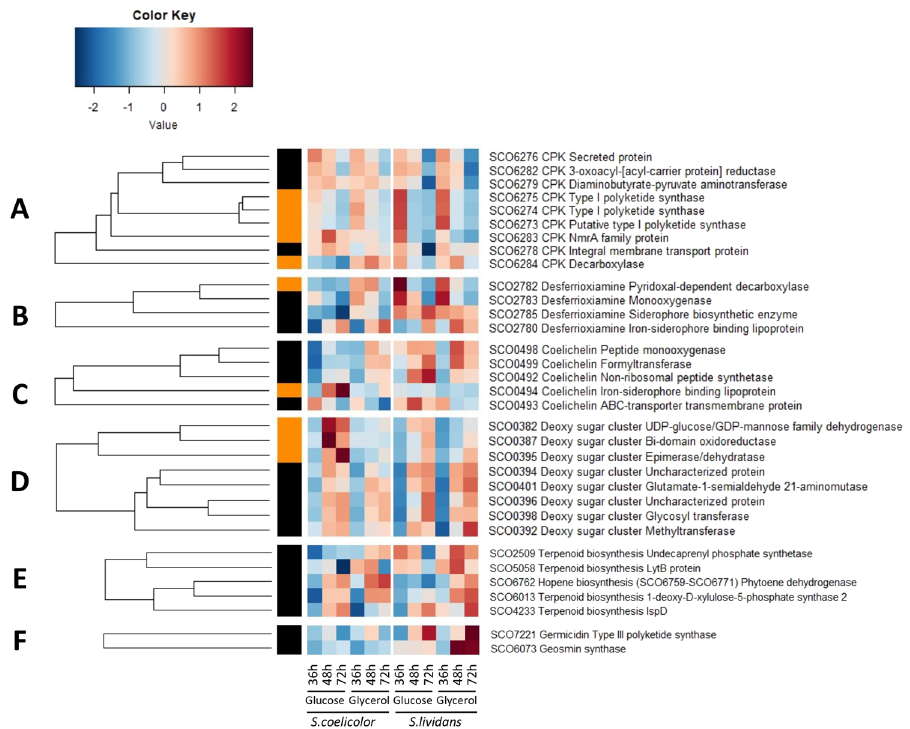
Figure 10. Independently generated heatmap representations of proteins belonging to others secondary metabolite pathways with significant abundance change (ANOVA, adjusted p value < 0.05) between S. coelicolor (M145) and S. lividans (TK24) with either glucose or glycerol as main carbon source, for 36, 48 and 72 h. Coelimycin cluster (A) . Desferroxamine cluster (B) . Coelichelin cluster (C) . Deoxysugar cluster (D) . Terpenoid biosynthesis cluster (E) . Others (F) . Protein identifiers are indicated as SCO numbers for both strains and by predicted functions. The quantification methods are displayed in the vertical bar indicating proteins quantified by Spectral Counting (orange) or XIC